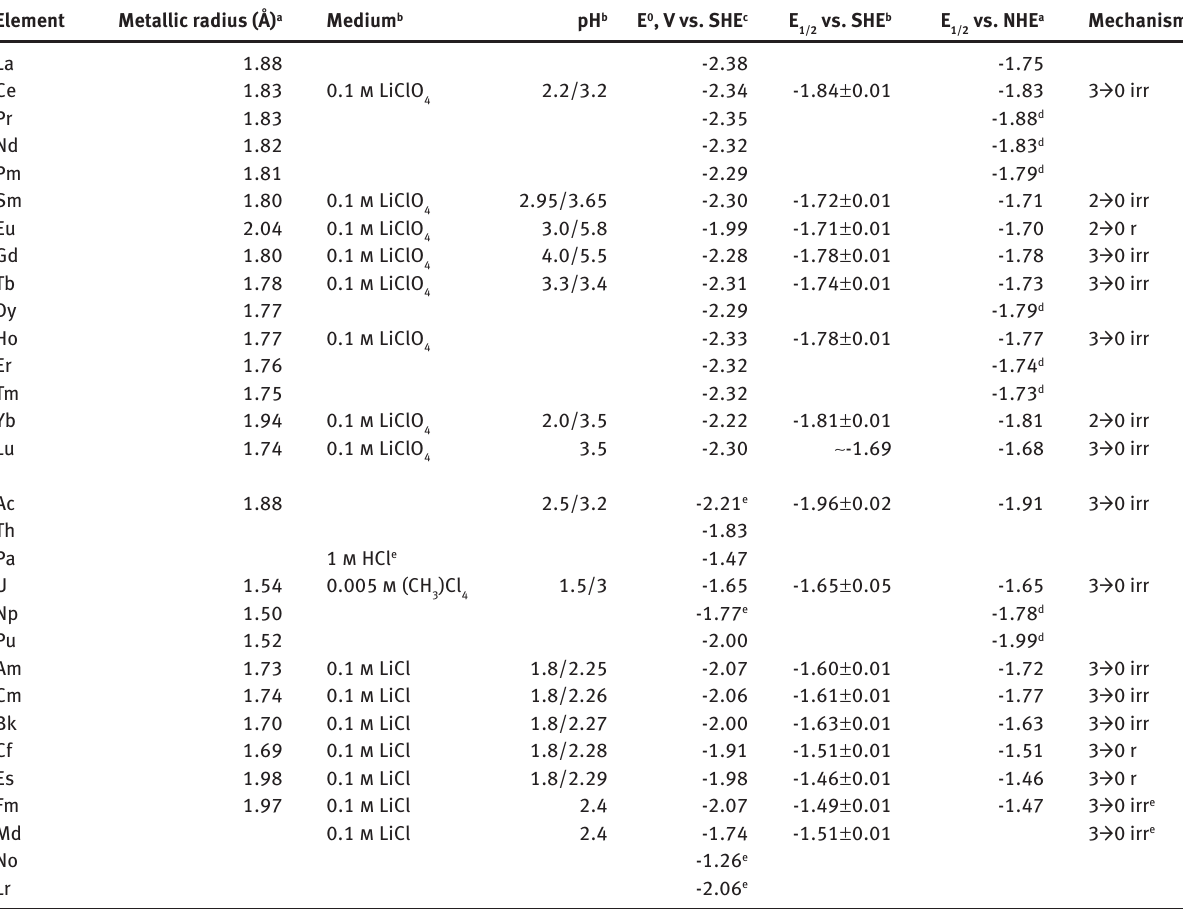
Table 3 Summary of electrochemical data of Ln and An with Hg electrodes.